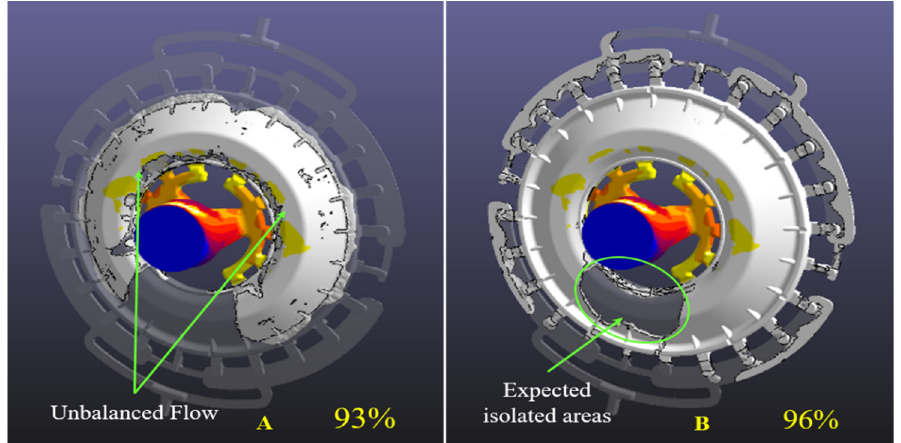
Figure 4. Simulation results of the melt flow for Case 1: ( A ) 93% filling; ( B ) 96% filling.